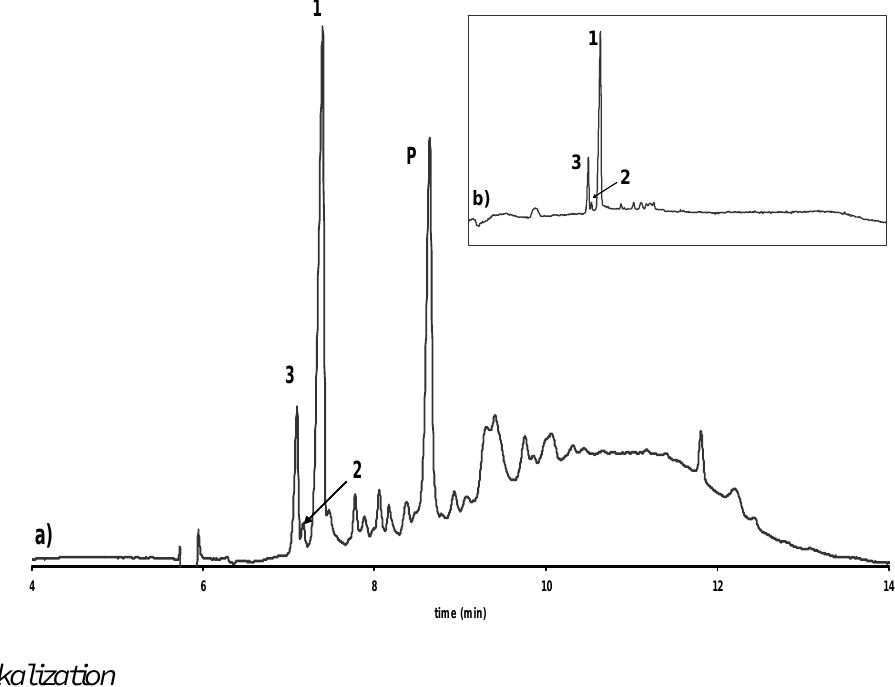
Figure 4 . Electropherogram showing the enantioselective separation of catechin and epicatechin in a) an extract of dark chocolate and b) isolated from this